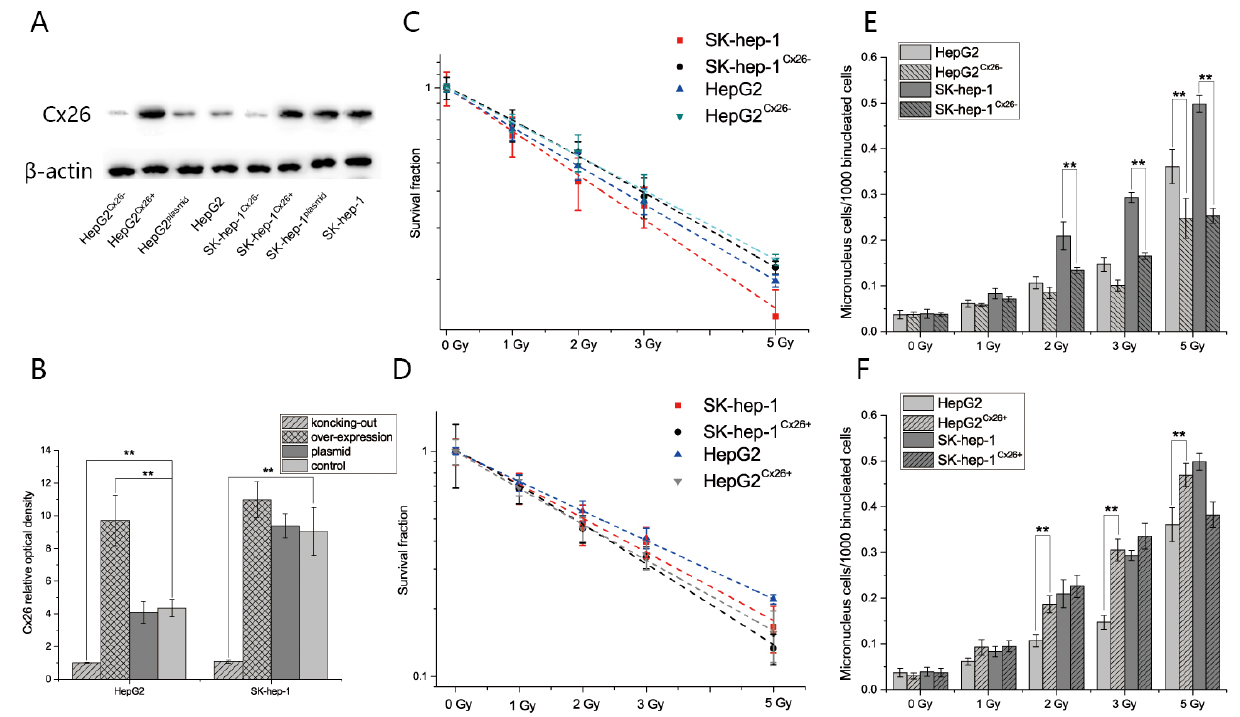
Figure 5. The difference in expression of Cx26 affects the radiosensitivity of HepG2 and SK-hep-1 cells. ( A ) The Cx26 expression in HepG2 and SK-hep-1 cells after knock-out or overexpression of Cx26. ( B ) Quantification of Cx26 expression in HepG2 and SK-hep-1 cells after knock-out or overexpression of Cx26. ( C ) The dose-survival curve of HepG2 Cx26 − and SK-hep-1 Cx26 − cells compared with control cells after X-ray irradiation. ( D ) The dose-survival curve of HepG2 Cx26+ and SK-hep-1 Cx26+ cells compared with control cells after X-ray irradiation. ( E ) The micronuclei formation rates of HepG2 Cx26 − and SK-hep-1 Cx26 − cells after X-ray irradiation. ( F ) The micronuclei formation rates of HepG2 Cx26+ and SK-hep-1 Cx26+ cells after X-ray irradiation. ** p < 0.01 compared between the two cells.